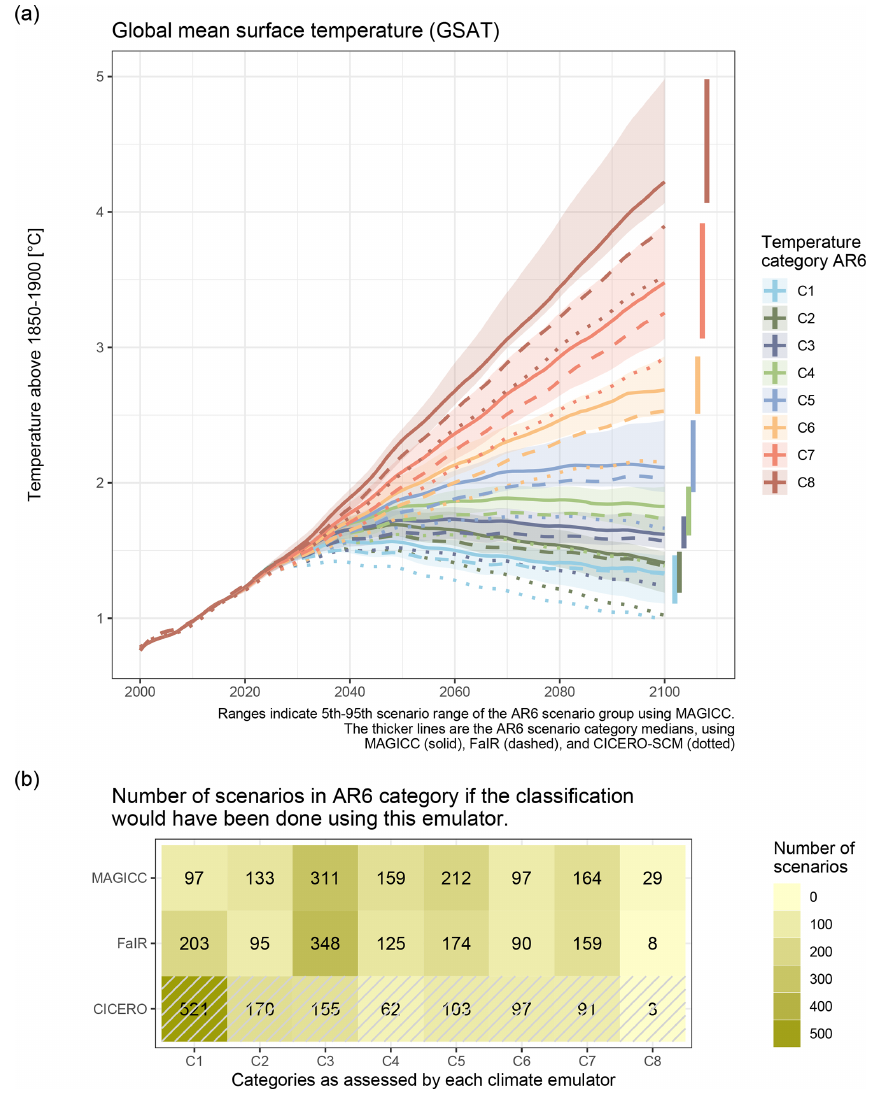
Figure 3. Median global surface temperatures above the mean of 1850–1900 as simulated for scenarios in the AR6DB, with scenarios grouped by the classification as in AR6 WGIII. Medians are shown for all three uses of climate emulators (CICERO-SCM: dotted, MAGICCv7.5.3: solid, and FaIRv1.6.2: dashed), while the 5th–95th percentile range is only shown for MAGICCv7.5.3. The number of scenarios classified in each group are shown in the bottom panel. CICERO-SCM numbers are hashed to indicate that AR6 WGI assessed especially the used parameterisations of MAGICCv7.5.3 and FaIRv1.6.2 to closely reflect the IPCC assessment, with CICERO-SCM for its AR6 calibration being used in WGIII only for sensitivity analysis to capture climatic uncertainty